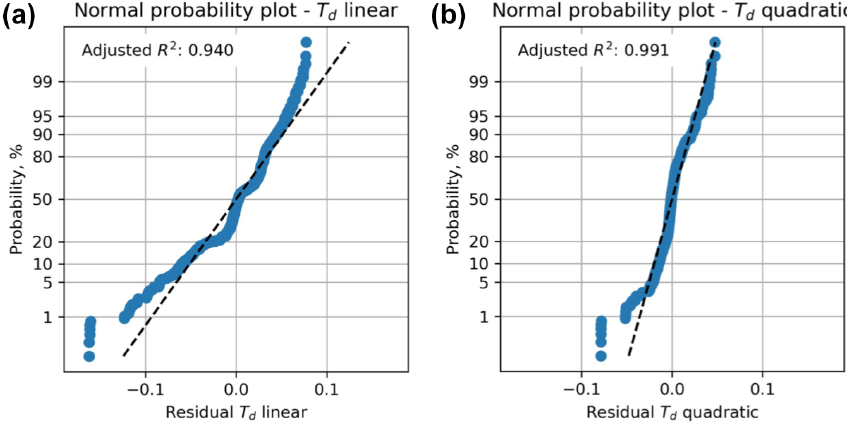
Figure A2. Residual plots for linear and quadratic response surfaces for dilation tendency ( T d ) using synthetic data. The quadratic fit has a higher value of the adjusted R 2 parameter and is therefore deemed better in this